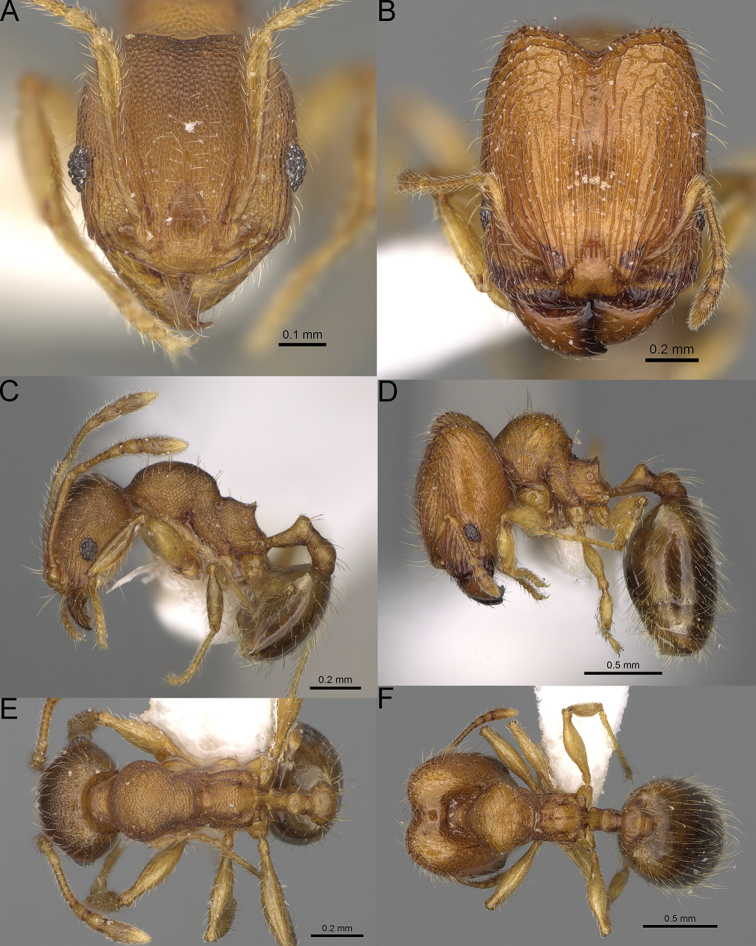
Pheidole
ehazoara sp. nov., full-face view (A), profile (C), and dorsal view (E) of paratype minor worker (CASENT0923186) and full-face view (B), profile (D), and dorsal view (F) of holotype major worker (CASENT0872059).